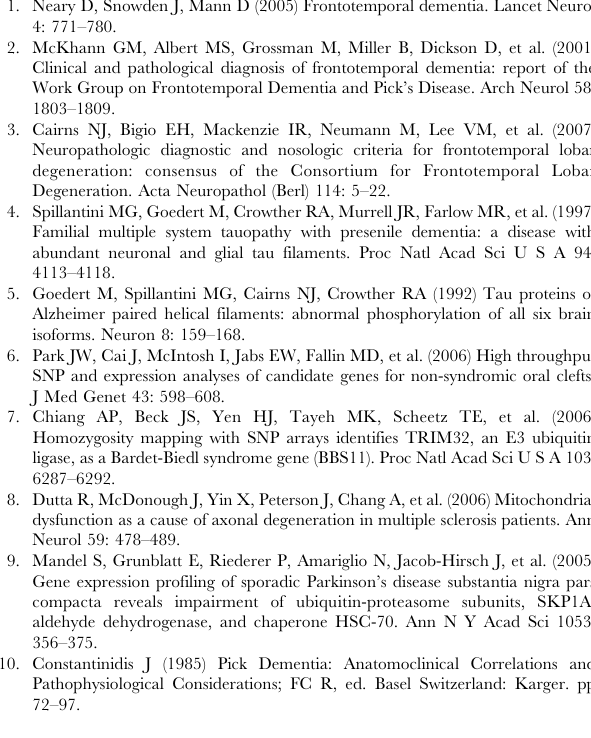
Table S2 Compiled table of all 790 probes detected to be significantly different from background and overlapping in at least two different pathologically defined groups. When possible probes are given in official gene symbol names. Gene symbol: official